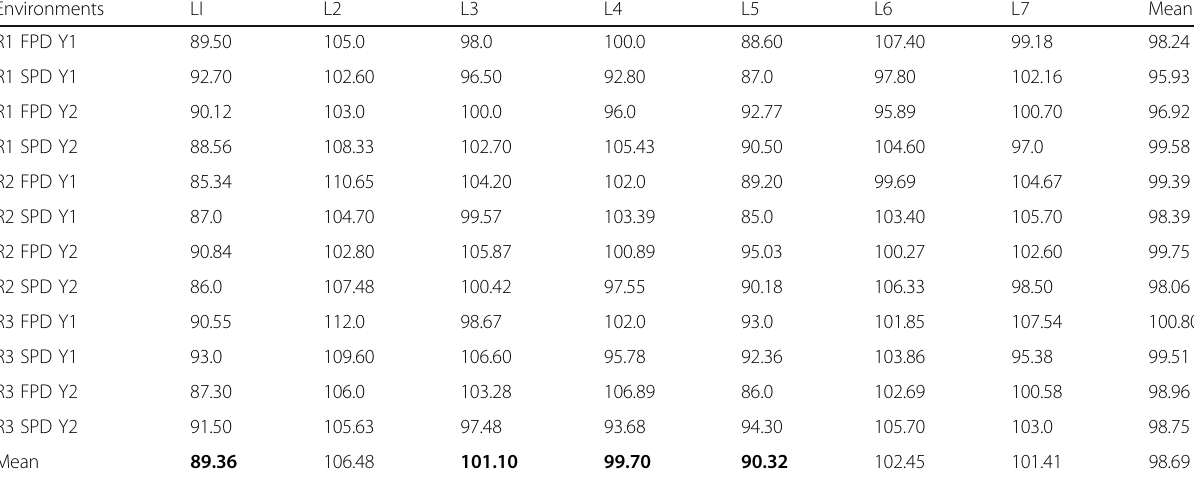
Table 4 The mean values for the seven rice entries under the 12 environments for plant height Environments LI L2